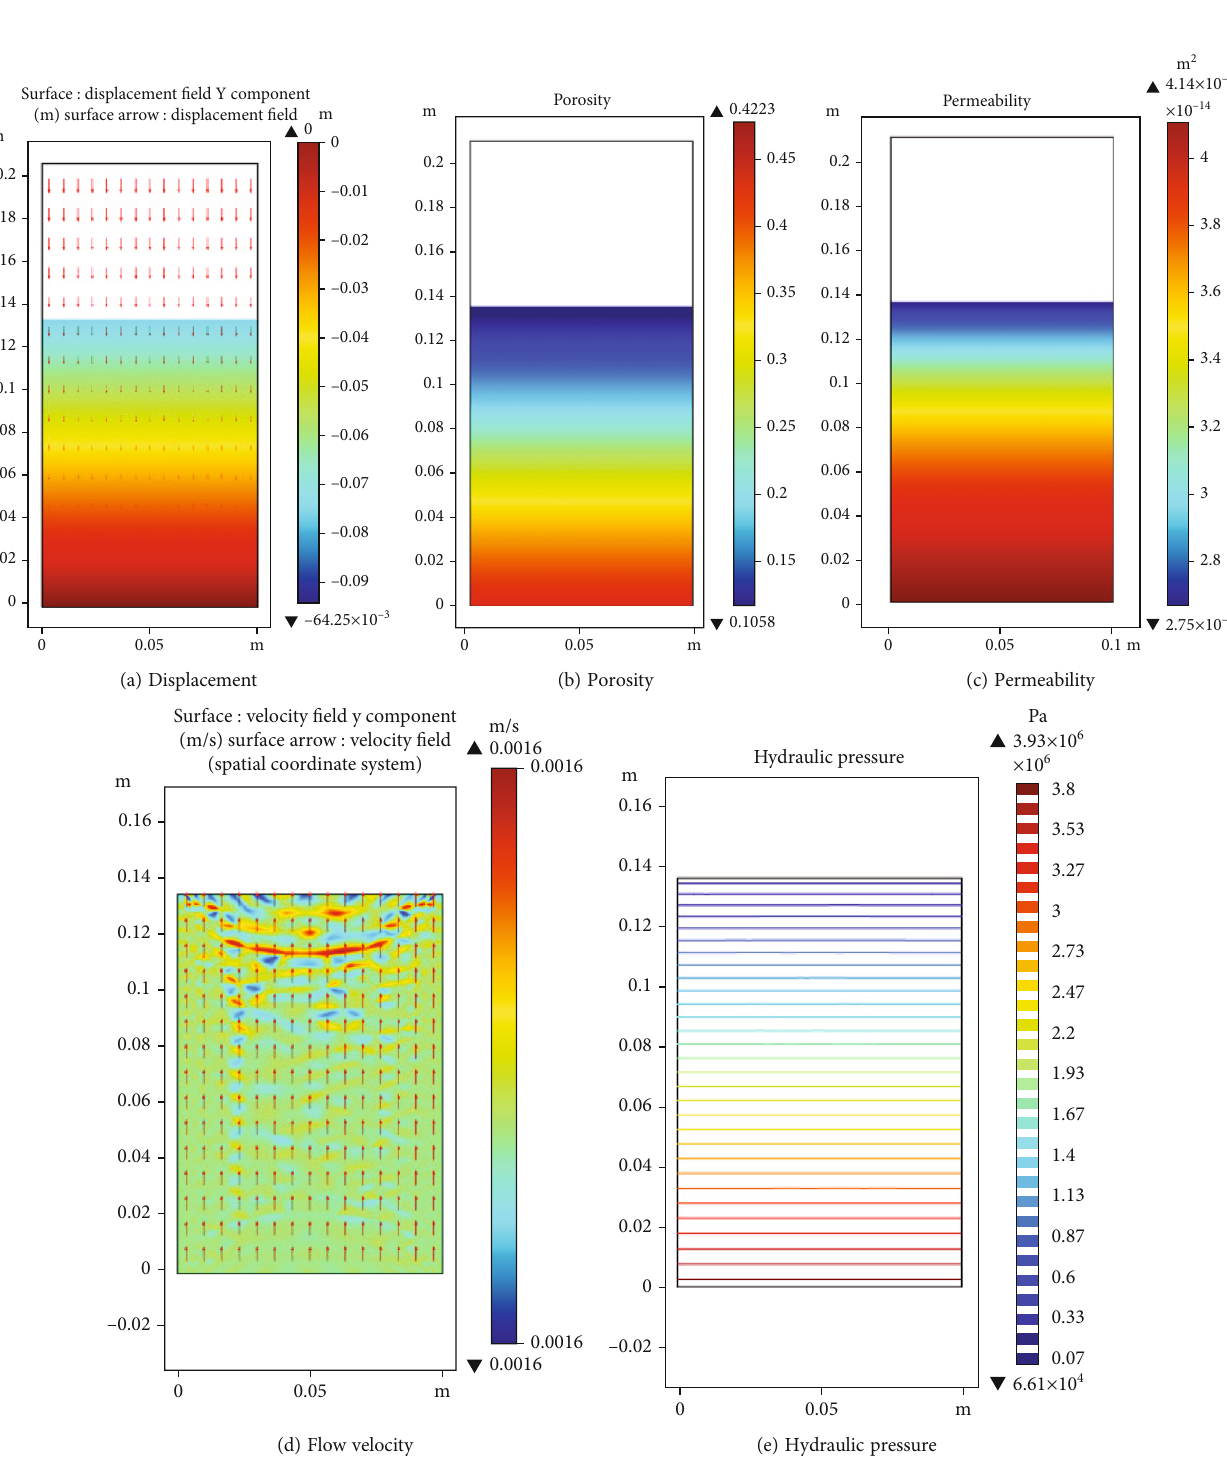
Figure 13: Seepage rules in the gangues with a size range of 10 ~